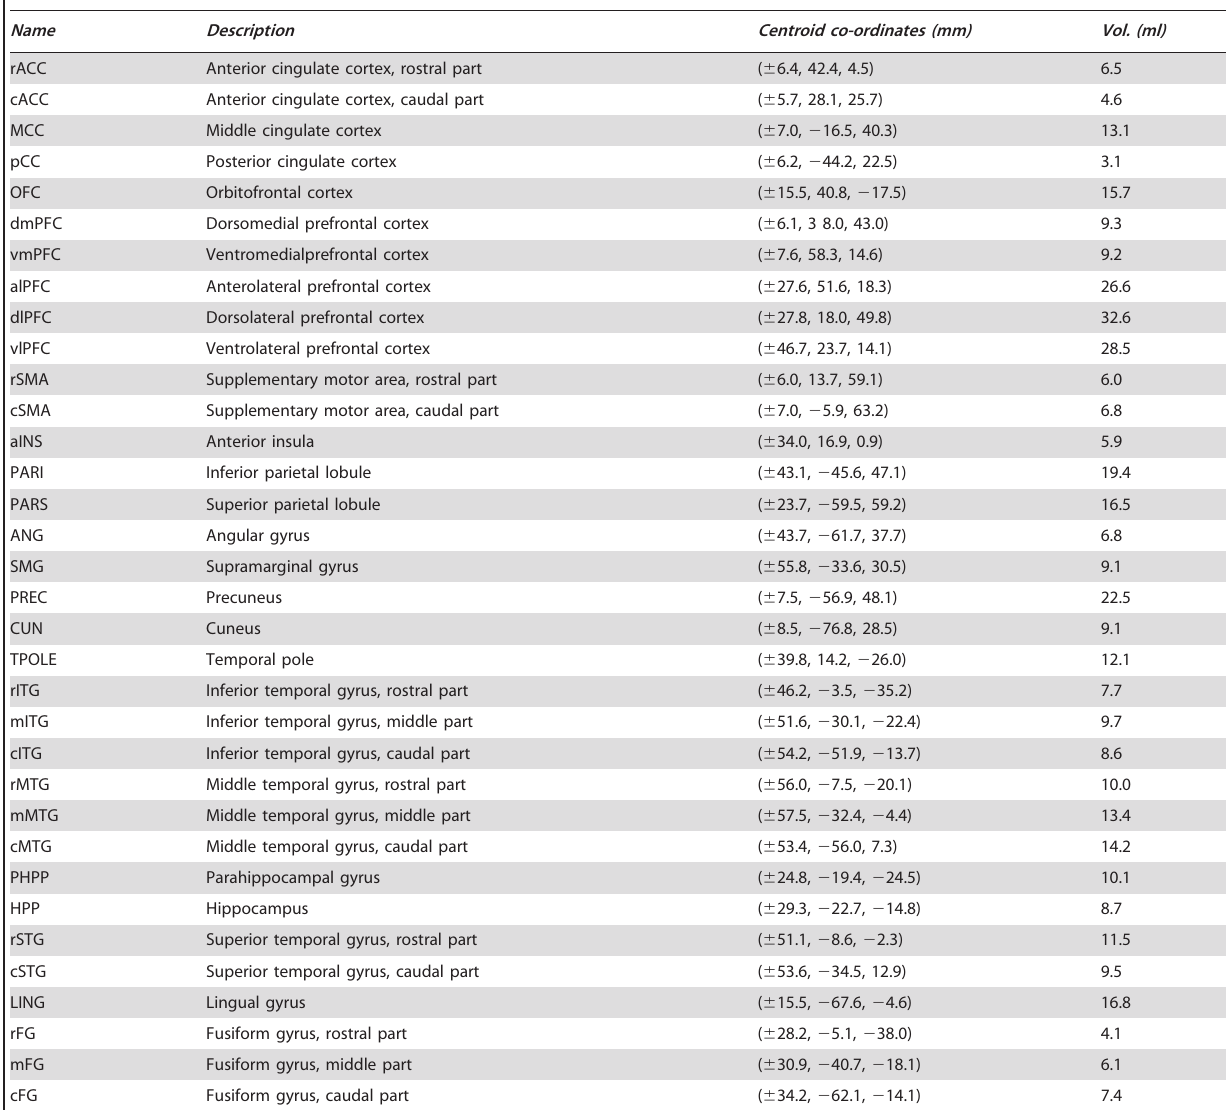
Table 1. Regions of Interest